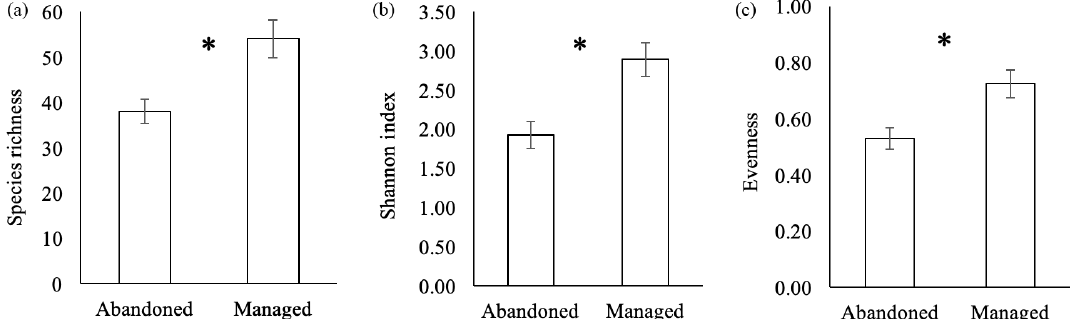
Figure 1. Plant species richness (a) , Shannon index (b) and evenness (c) in abandoned and managed meadows. ∗ denotes significant differ- ence between management types ( p < 0 . 05). Means ±